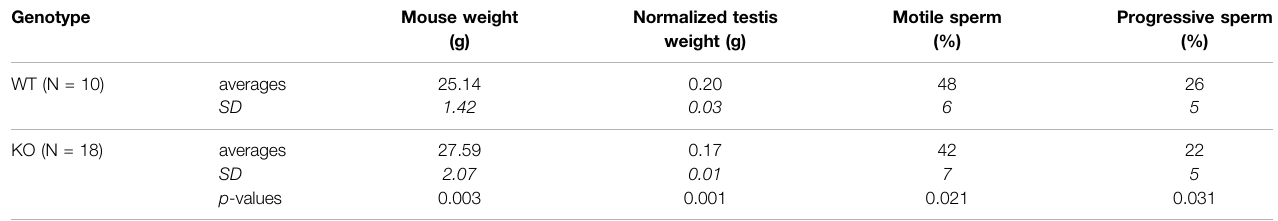
TABLE 1 | Testis and sperm analysis for the Map2k7- α 1 promotor KO animals versus wild type (WT) animals. Testis weights were normalized with mouse body weights. Sperm analysis was done with a CEROS Sperm Analyzer (Hamilton Thorne, Beverly MA) setup. Two-sided t-tests were done to calculate the p -values. SD is standard deviation (in italics).